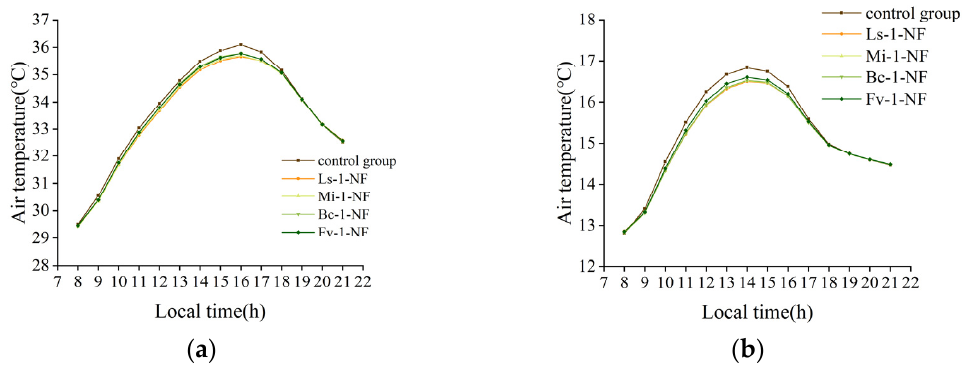
Figure 13. Effects of arbor species on air temperature in summer ( a ) and winter ( b ).